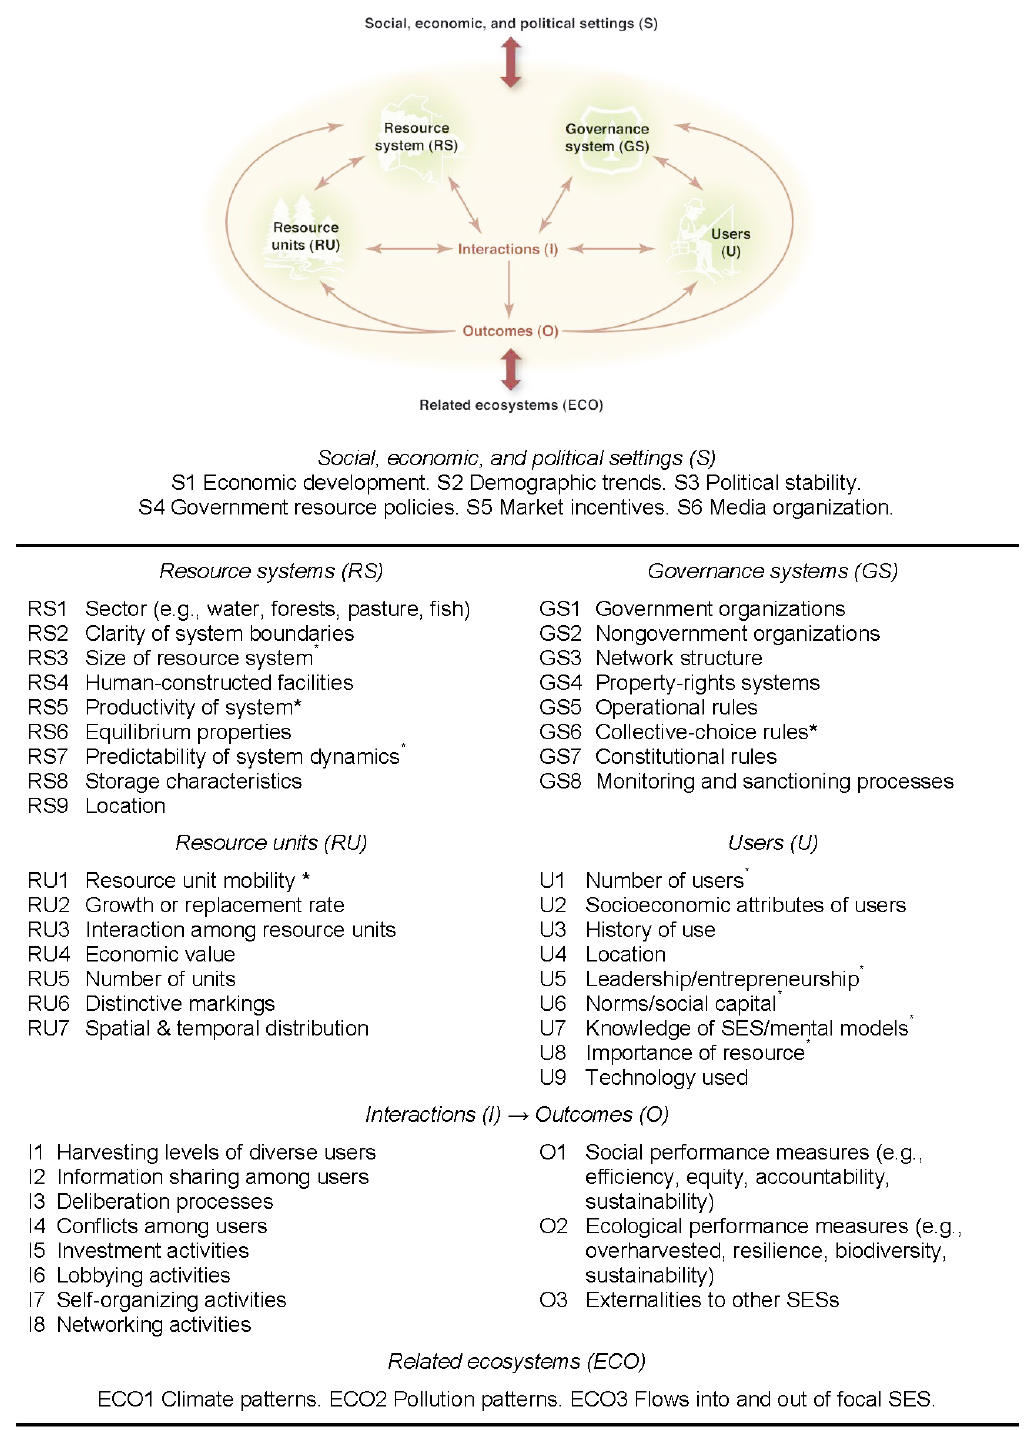
Fig. 2 . Social–ecological system (SES) framework (Ostrom